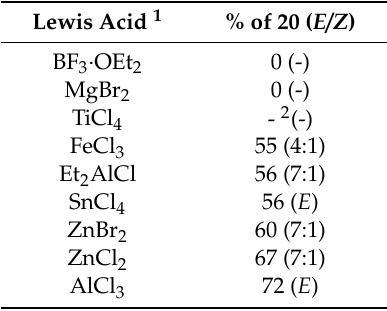
Table 3. The catalytic results in the synthesis of vitamin K 1 , K 1 -chromanol, and C2-alkylated product from menadiol [66].